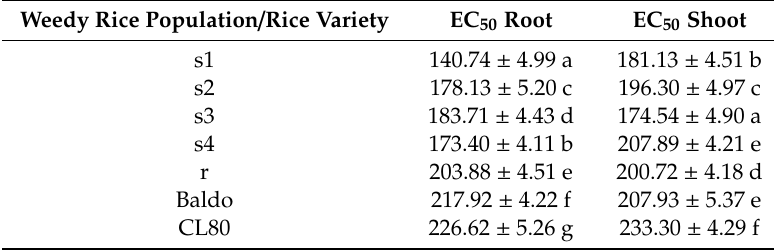
Table 4. NaCl concentrations (mM) required to reduce by 50% root and shoot length (EC 50 ± SE) of the tested weedy rice populations and rice varieties. Values sharing the same letters are not significantly di ff erent according to the LSD test with Bonferroni adjustment ( α ≤